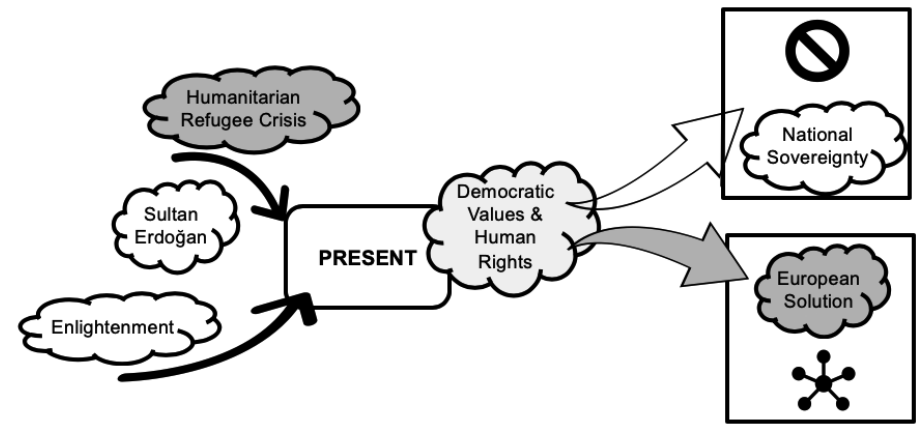
Figure 6. Comedy-romance (cultural boundary, white clouds) and comedy-irony (civic boundary, grey clouds) in Stage